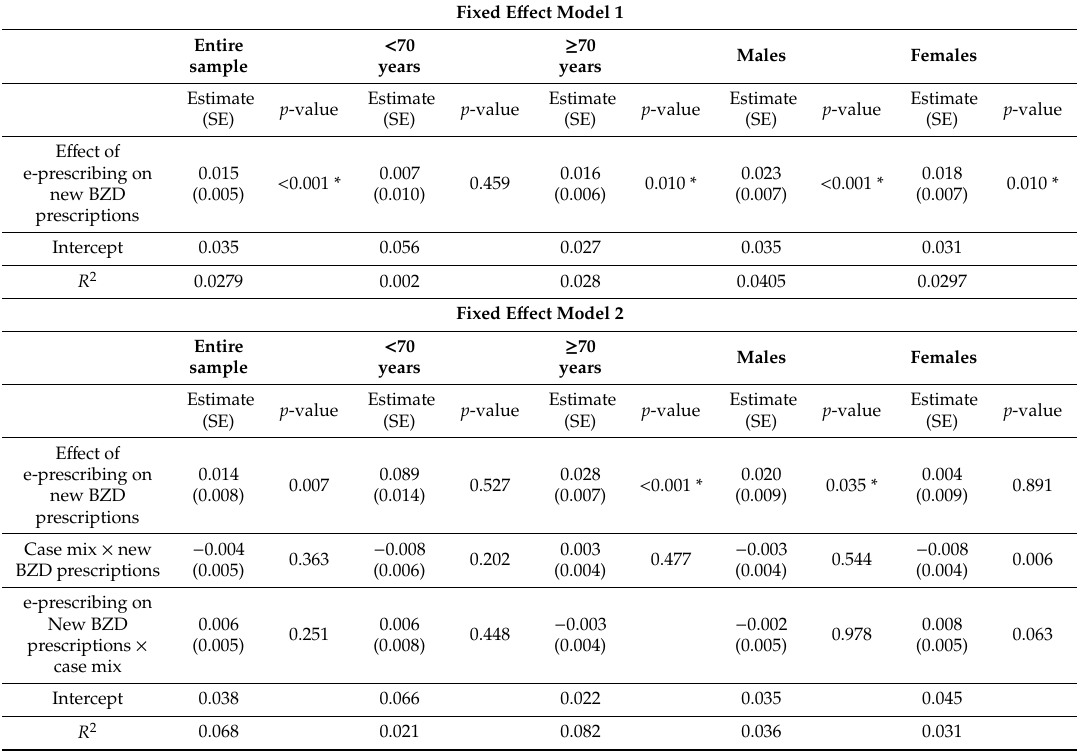
Table 3. E ff ect of e-prescribing implementation on new BZD prescriptions in the entire population by age classes and gender.